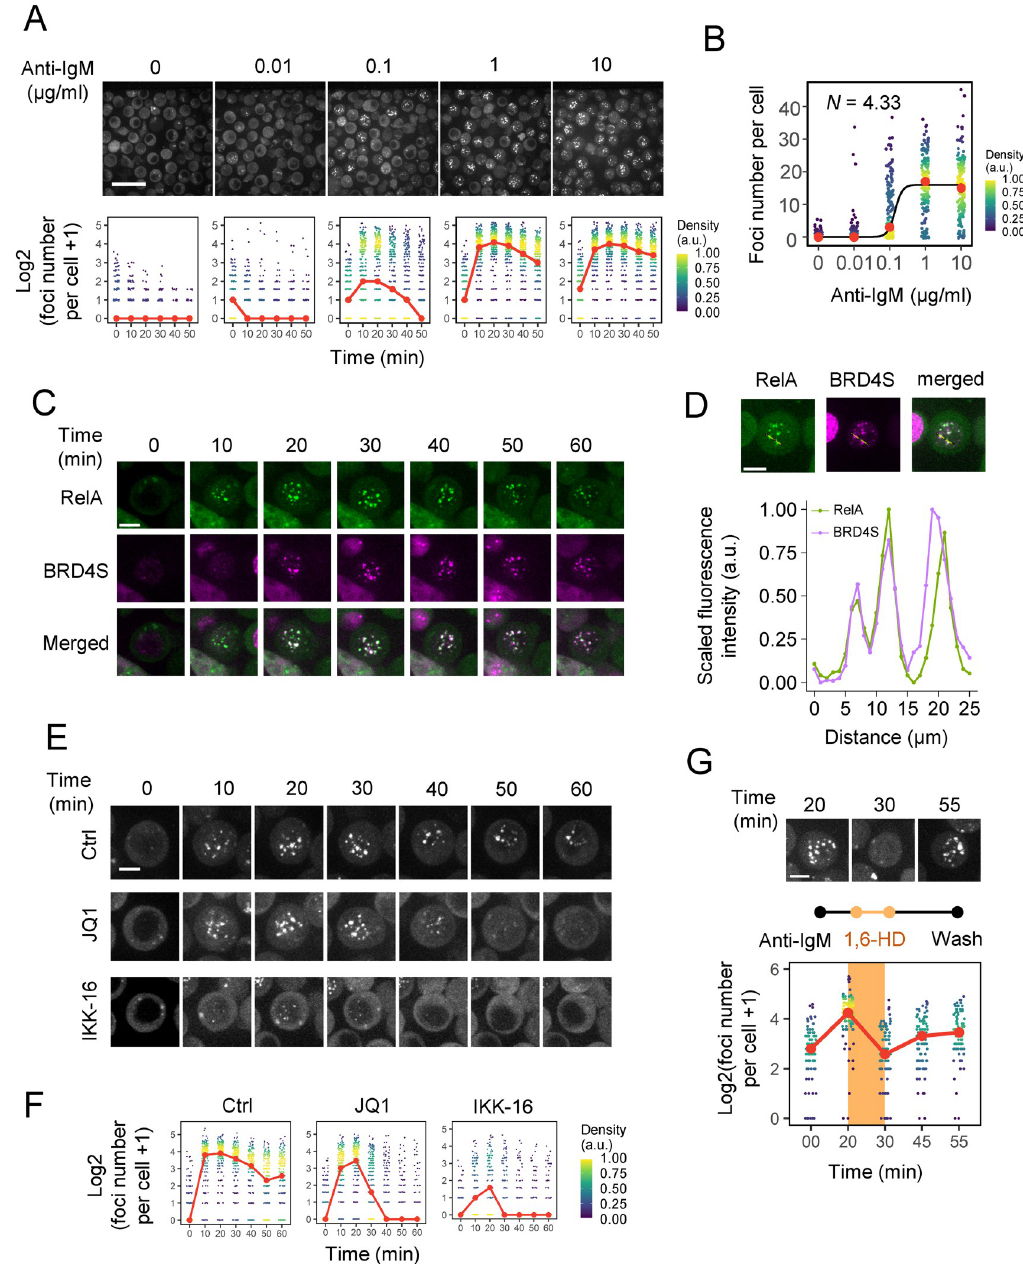
Fig 1. RelA foci demonstrate SE-like properties. (A) Representative real-time fluorescence micrographs of an individual RelA-GFP-expressing DT40 cell upon stimulation with 10 μ g/mL anti-IgM (scale bar, 25 μ m) and the quantification of the number of foci per cell across various anti-IgM doses (red points represent the median). (B) Quantification of the number of foci per cell after 20 min of various doses of anti-IgM stimulation (red dots represent the median). The median value was fitted to the Hill equation, resulting in a Hill coefficient of 4.33. (C) Time-lapse fluorescence micrograph of DT40 cells co-expressing mKate2-BRD4S and RelA-GFP upon stimulation with 10 μ g/mL anti-IgM (scale bar, 5 μ m). (D) Quantification of the co- localization of mKate2-BRD4S and RelA-GFP 20 min after anti-IgM stimulation. (E) Representative fluorescence micrographs of RelA-GFP-expressing DT40 cells pre-treated with 5 μ M JQ1 for 60 min or 4 μ M IKK-16 for 60 min. (F) Quantification of RelA foci from (E). (G) Quantification of RelA-GFP foci before treatment, after 1,6-hexanediol treatment and washing. The threshold of foci detection was lowered to compensate for the low fluorescence intensities of the recovering